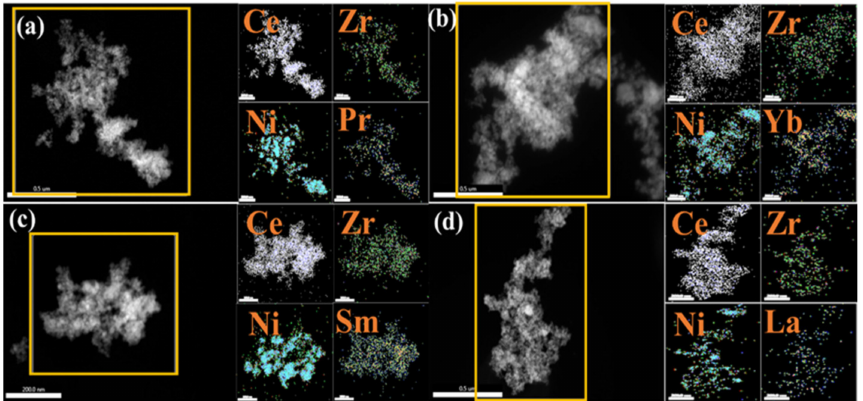
Figure 4. STEM-EDS element mapping images showing the spatial distribution of Ce, Zr, Ni, and R (R = La, Sm, Pr, Yb) elements: ( a ) 15Ni2Pr/M-Ce80Zr20, ( b ) 15Ni2Yb/M-Ce80Zr20, ( c ) 15Ni2Sm/M- Ce80Zr20, ( d )